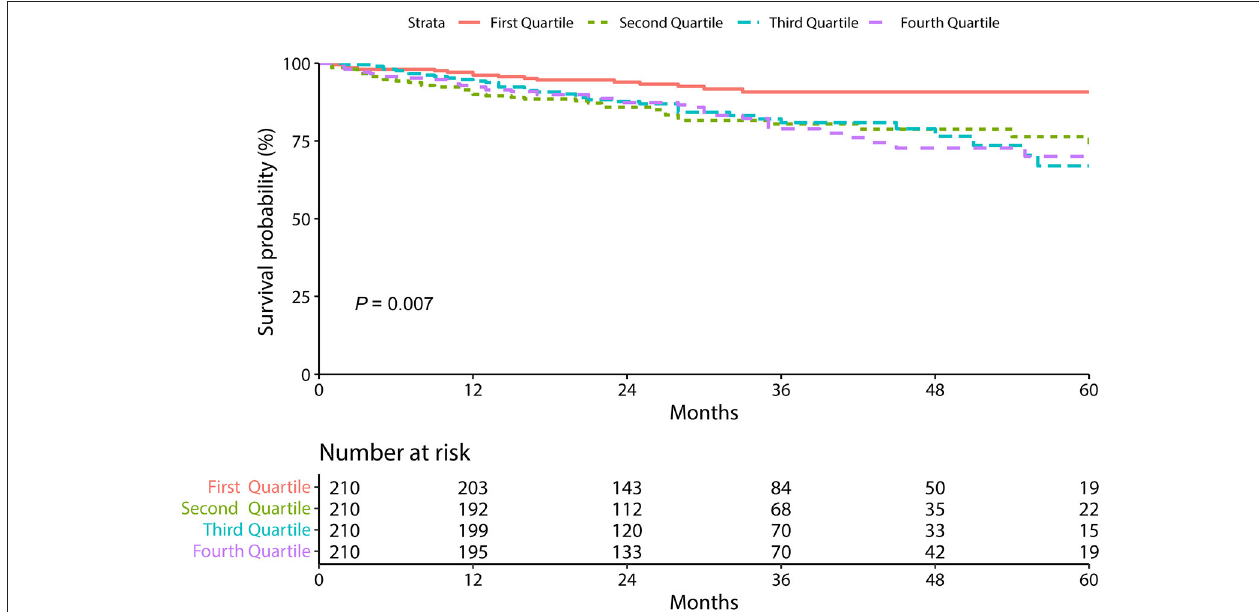
FIGURE 1 | The Kaplan-Meier survival curves according to circulating retinol-binding protein 4 level.